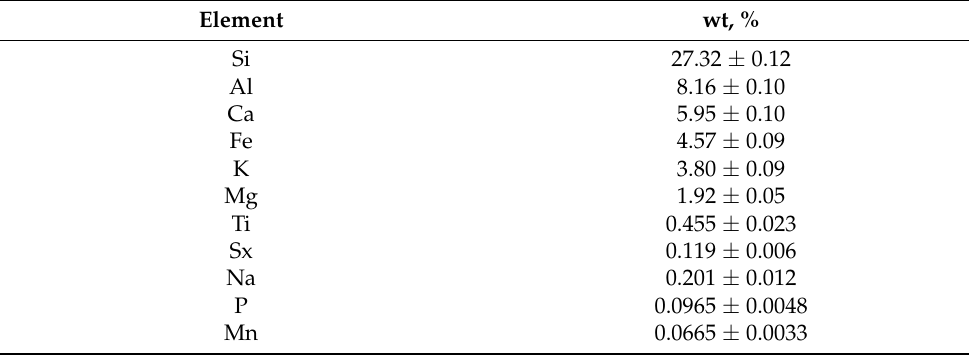
Table 4. X-ray fluorescence of the